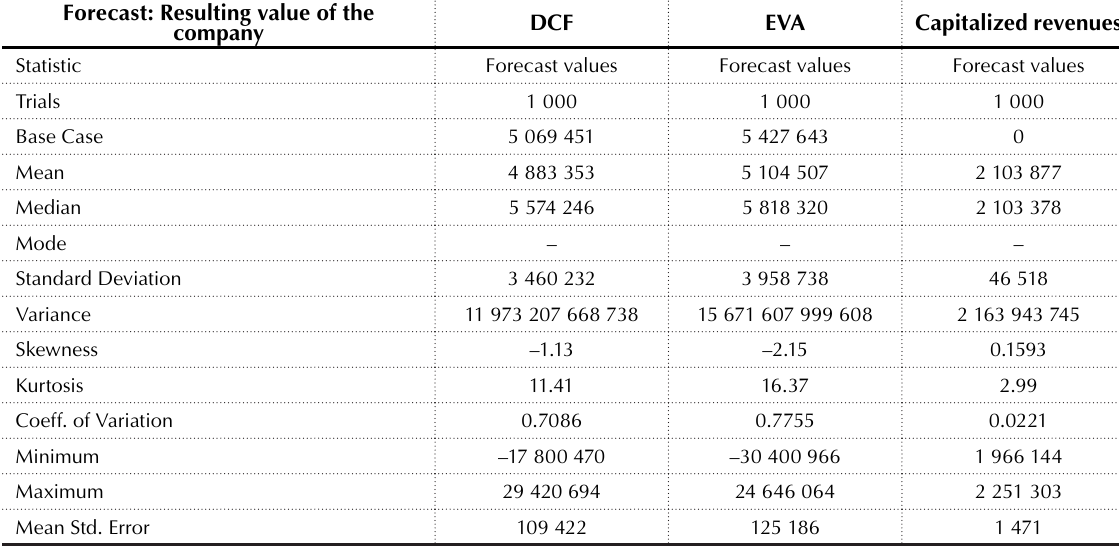
Table 1. Comparison of characteristics of distribution of company value – the method of net capitalized revenues